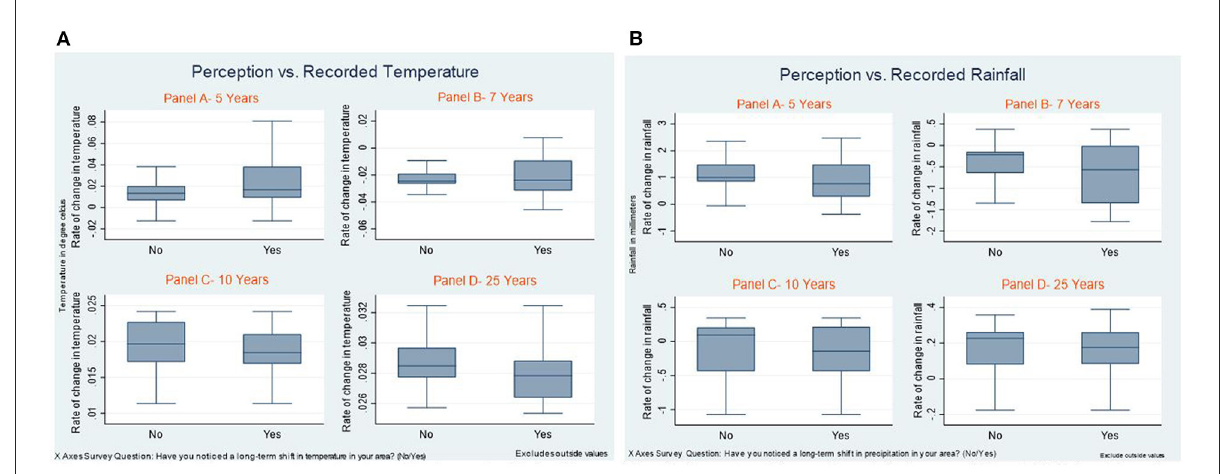
FIGURE2 (A) Comparison of farmers who noticed a long-term shift in temperature (Yes) and those who did not (No) against the rate of change in temperature. (B) Comparison of farmers who noticed a long-term shift in rainfall (Yes) and those who did not (No) against the rate of change in rainfall.